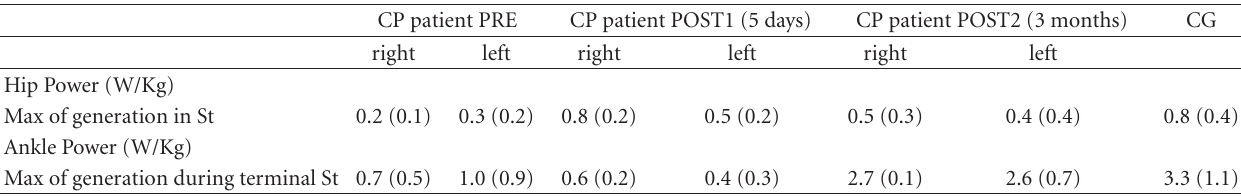
Table 2: Summary of kinetic parameters (mean and standard deviation) for analysed patient (CP patient; right and left side) in the examined sessions and normative data (Control Group, CG). Max: Maximum value; St: Stance